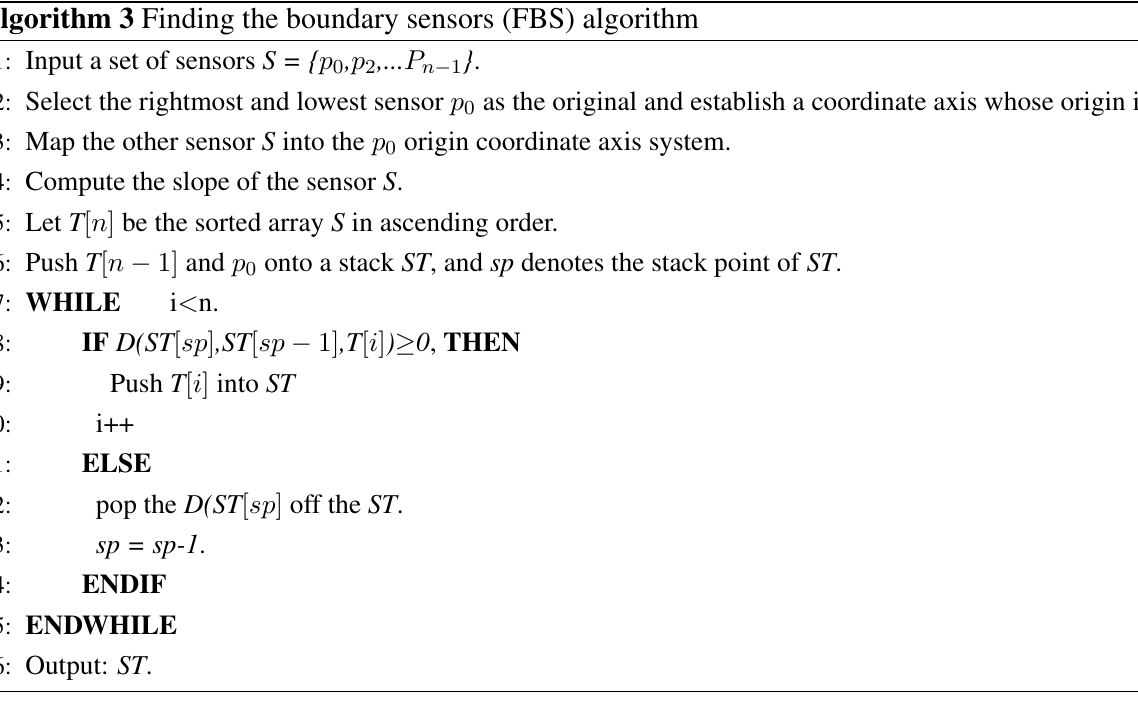
Algorithm 3 Finding the boundary sensors (FBS)